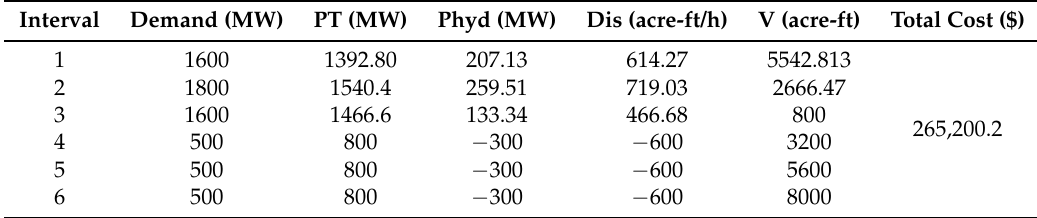
Table 11. Power flow and cost optimization with the improved APSO algorithm implementation on the non-cascaded pumped-storage STHTS problem considering valve point loading.